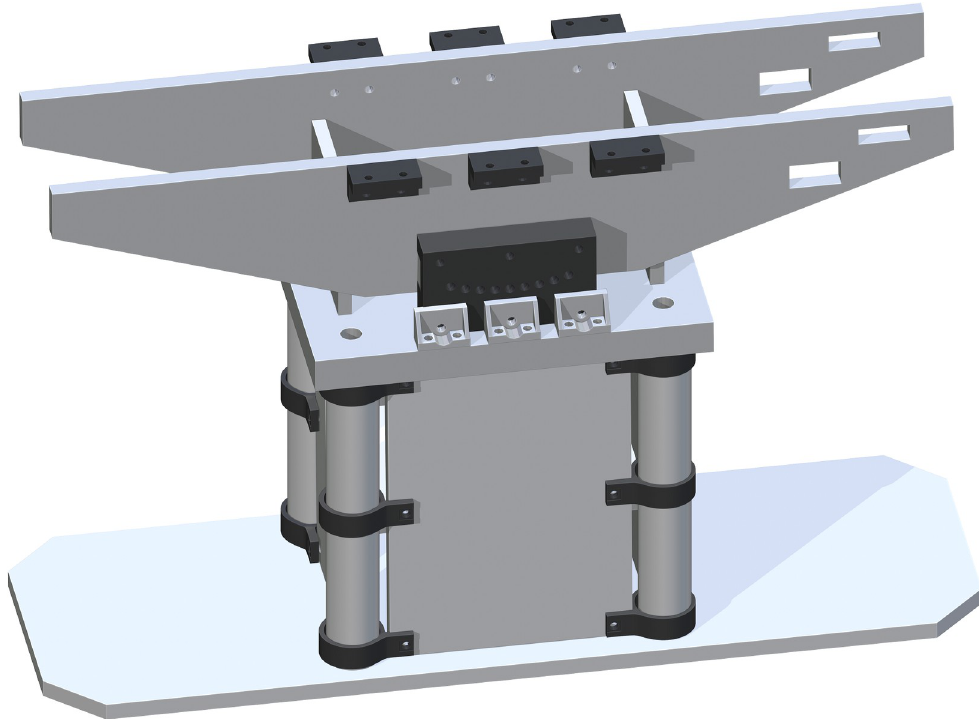
Fig 12. Final attachments of table top